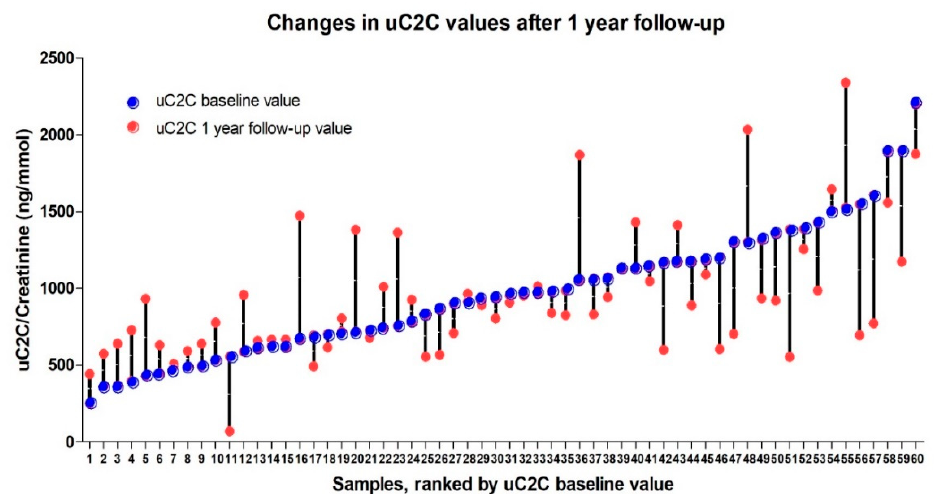
Figure 4. The individual dynamics of uC2C values (pre-TKR and 12 months after TKR) ranked by baseline uC2C value.